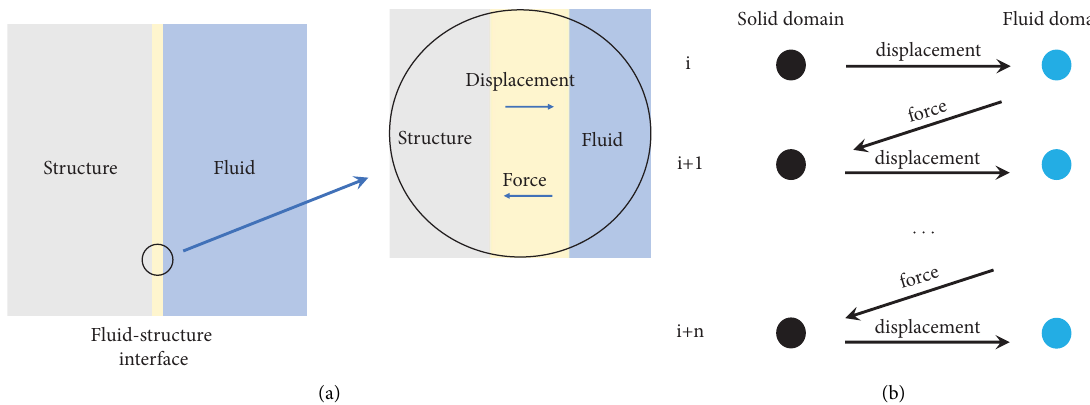
Figure 4: Schematic diagram of fuid-structure coupling. (a) Fluid-structure interface. (b) Iteration and transfer of